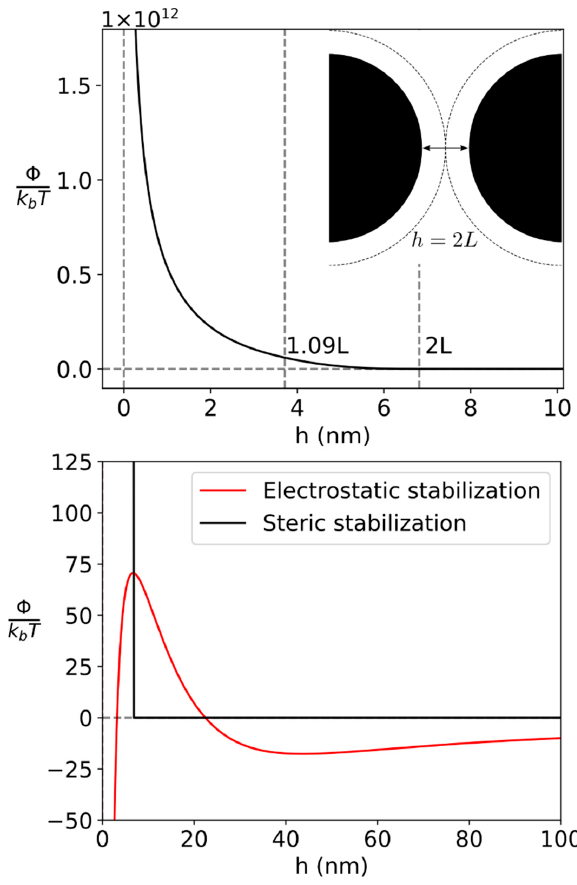
Figure 7. Interparticle potential for MGNS sterically stabilized with Triton X100 (top). From left to right, the vertical dashed lines indicate particle separations of 0 L, 1.09 L, and 2 L. The inset diagram shows approaching particles at a particle separation of 2 L. The interparticle potential for sterically stabilized MGNS is compared with the same for an electrostatically stabilized MGNS dispersion obtained from DLVO theory (bottom) [24].